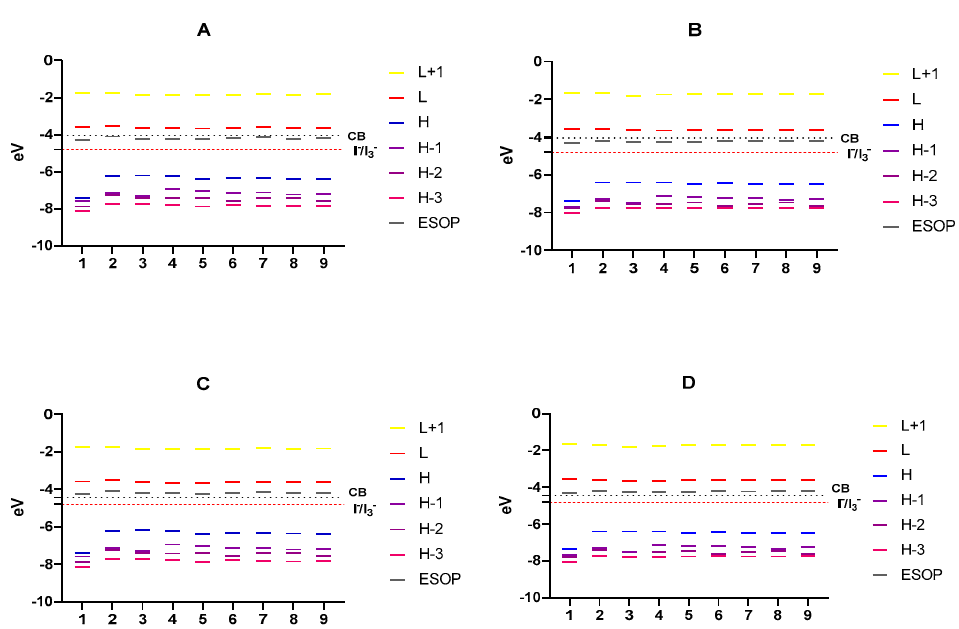
Figure 4. Level alignment of each compound regarding TiO 2 (( A ) in vacuum and ( B ) in methanol) and ZnO (( C ) in vacuum and ( D ) in methanol). Alignment regarding electrolyte I − /I 3 − is shown in each case. Values for TiO 2 and ZnO have been obtained from references [48,49].